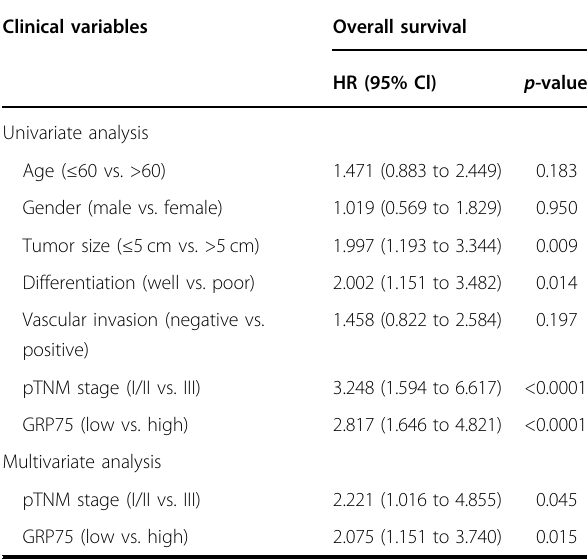
Table 1 Univariate and multivariate analyses of factors associated with overall survival of GC patients ( n = 116).